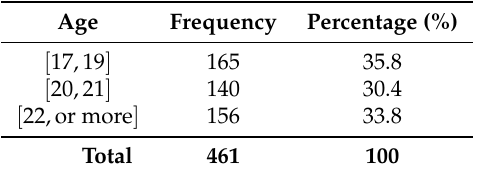
Table 2. Percentage distribution of respondents by age.